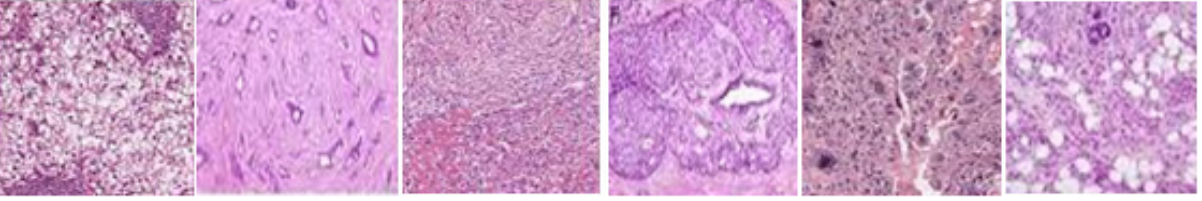
Figure 1. Sample Biopsy